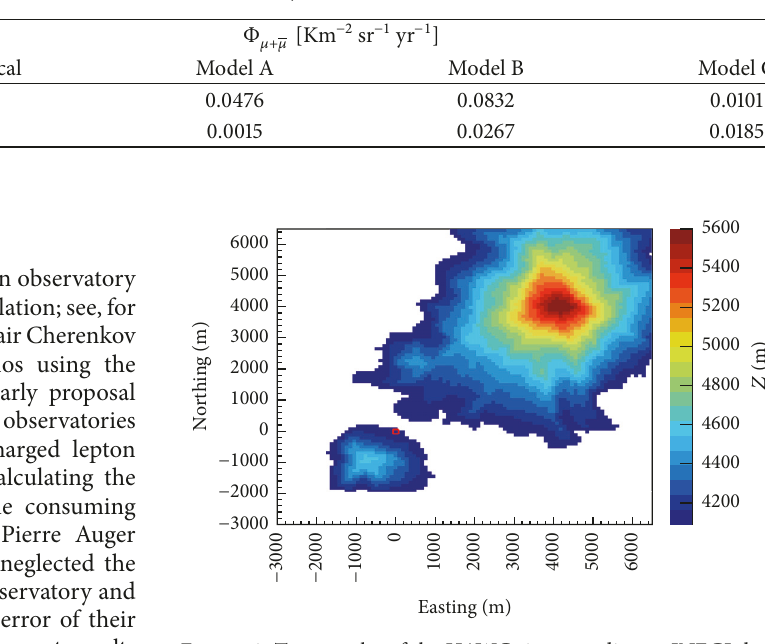
Figure 2: Topography of the HAWC site according to INEGI data. One can see two mountains, the Sierra Negra volcano at bottom left and the much larger Pico de Orizaba volcano on the top right. The small red rectangle, at the origin of the coordinate system, indicates the location and dimensions of the HAWC